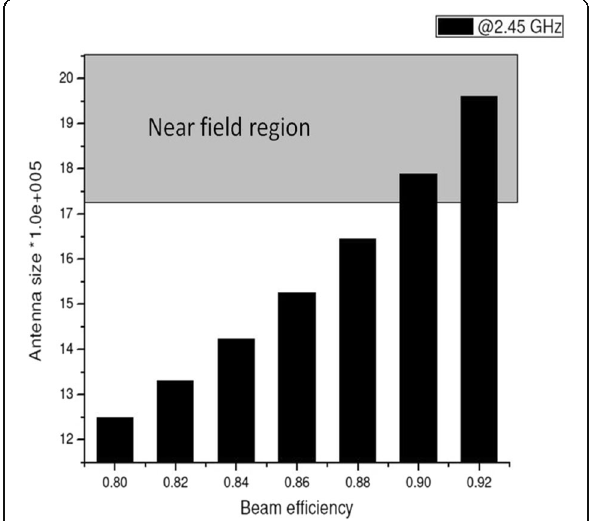
Fig. 7 Antenna size (m 2 ) variation with Beam efficiency at 2.45 GHz for case4 (2.5-GW